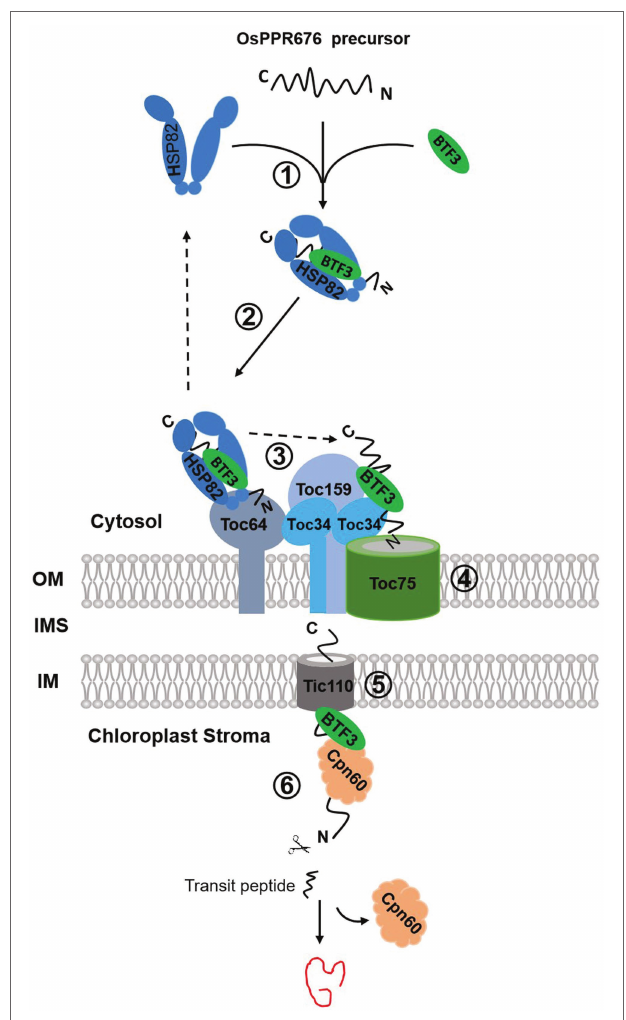
FIGURE 7 | The proposed chloroplast import pathways of OsPPR676. OsPPR676, synthesized as precursor proteins in the cytosol, will form a complex with OsHSP82 and Osj10gBTF3 to prevent degradation ( ① ). The formed OsHSP82-Osj10gBTF3-OsPPR676 complex is targeted to Toc64 via the interaction between Toc64 and OsHSP82 as well as Osj10gBTF3 ( ② ). Subsequently, OsPPR676 and Osj10gBTF3 are delivered to Toc34 by a GTP-dependent association of Toc64 with Toc34 ( ③ ), with a release of OsHSP82 back to the cytosol. Next, the intrinsic GTPase activities of Toc34 and Toc159 facilitates Osj10gBTF3 and OsPPR676 to cross the outer membrane via Toc75 ( ④ ). After crossing the outer membrane of chloroplast, Osj10gBTF3 enters the stroma through the inner chloroplast membrane channel protein Tic110 ( ⑤ ). Once entered into the stroma, Osj10gBTF3 recruits the stromal chaperone OsCpn60 to aid the fold or assembly of OsPPR676 into a mature form or Osj10gBTF3 may be itself chaperoned by Cpn60 upon import into the chloroplast, independent of OsPPR676 ( ⑥ ). The solid arrow represents the steps supported by our data; the dotted arrow represents the steps of the data from the references. OM, outer membrane; IMS, intermembrane space; and IM, inner